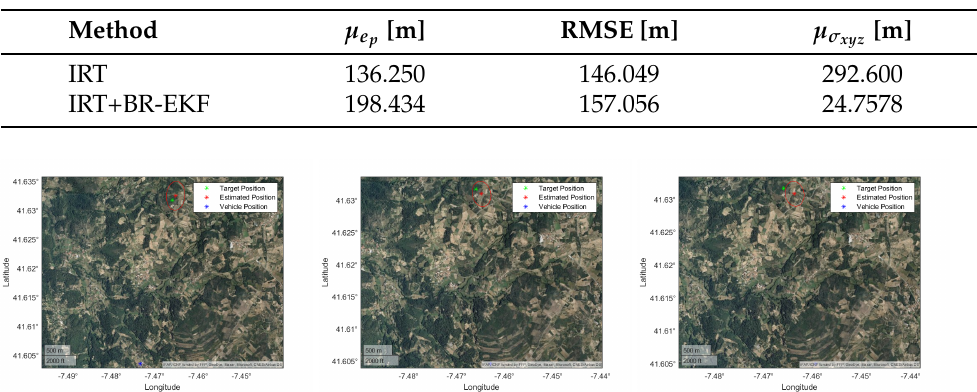
Table 11. Portuguese Air Force IRT and IRT+BR-EKF results.